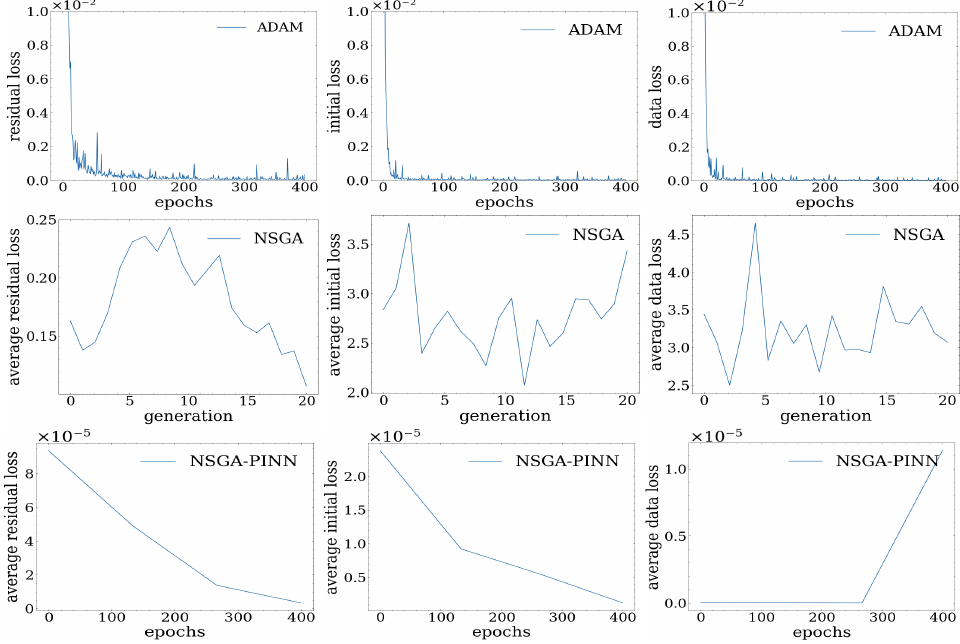
Figure 3. Inverse pendulum problem: Group of figures from left to right columns show each loss value by using different training method .